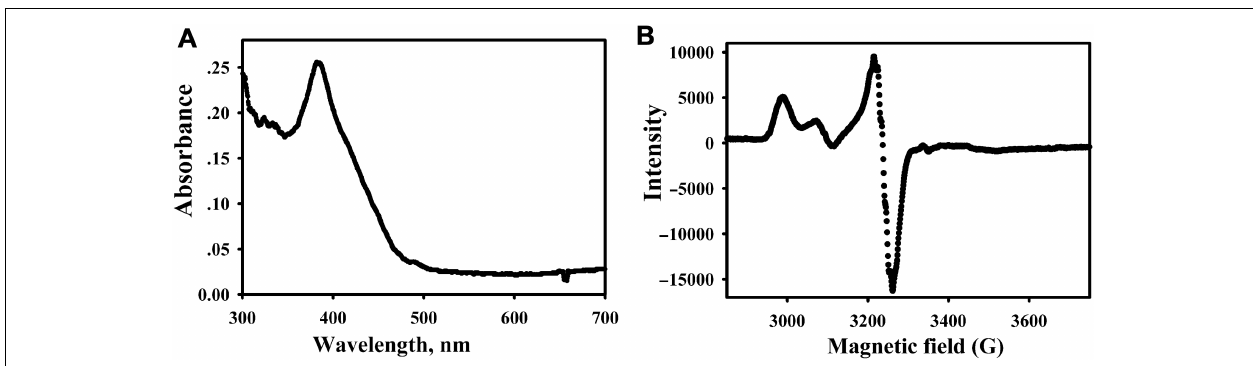
FIGURE 4 | Spectra of the purified MCR (9.4 μ M heterotrimer, 1.3 mg ml − 1 ) from CO-activated cells. UV-visible (A) and EPR spectrum (B) of MCR purified from CO-activated cells.